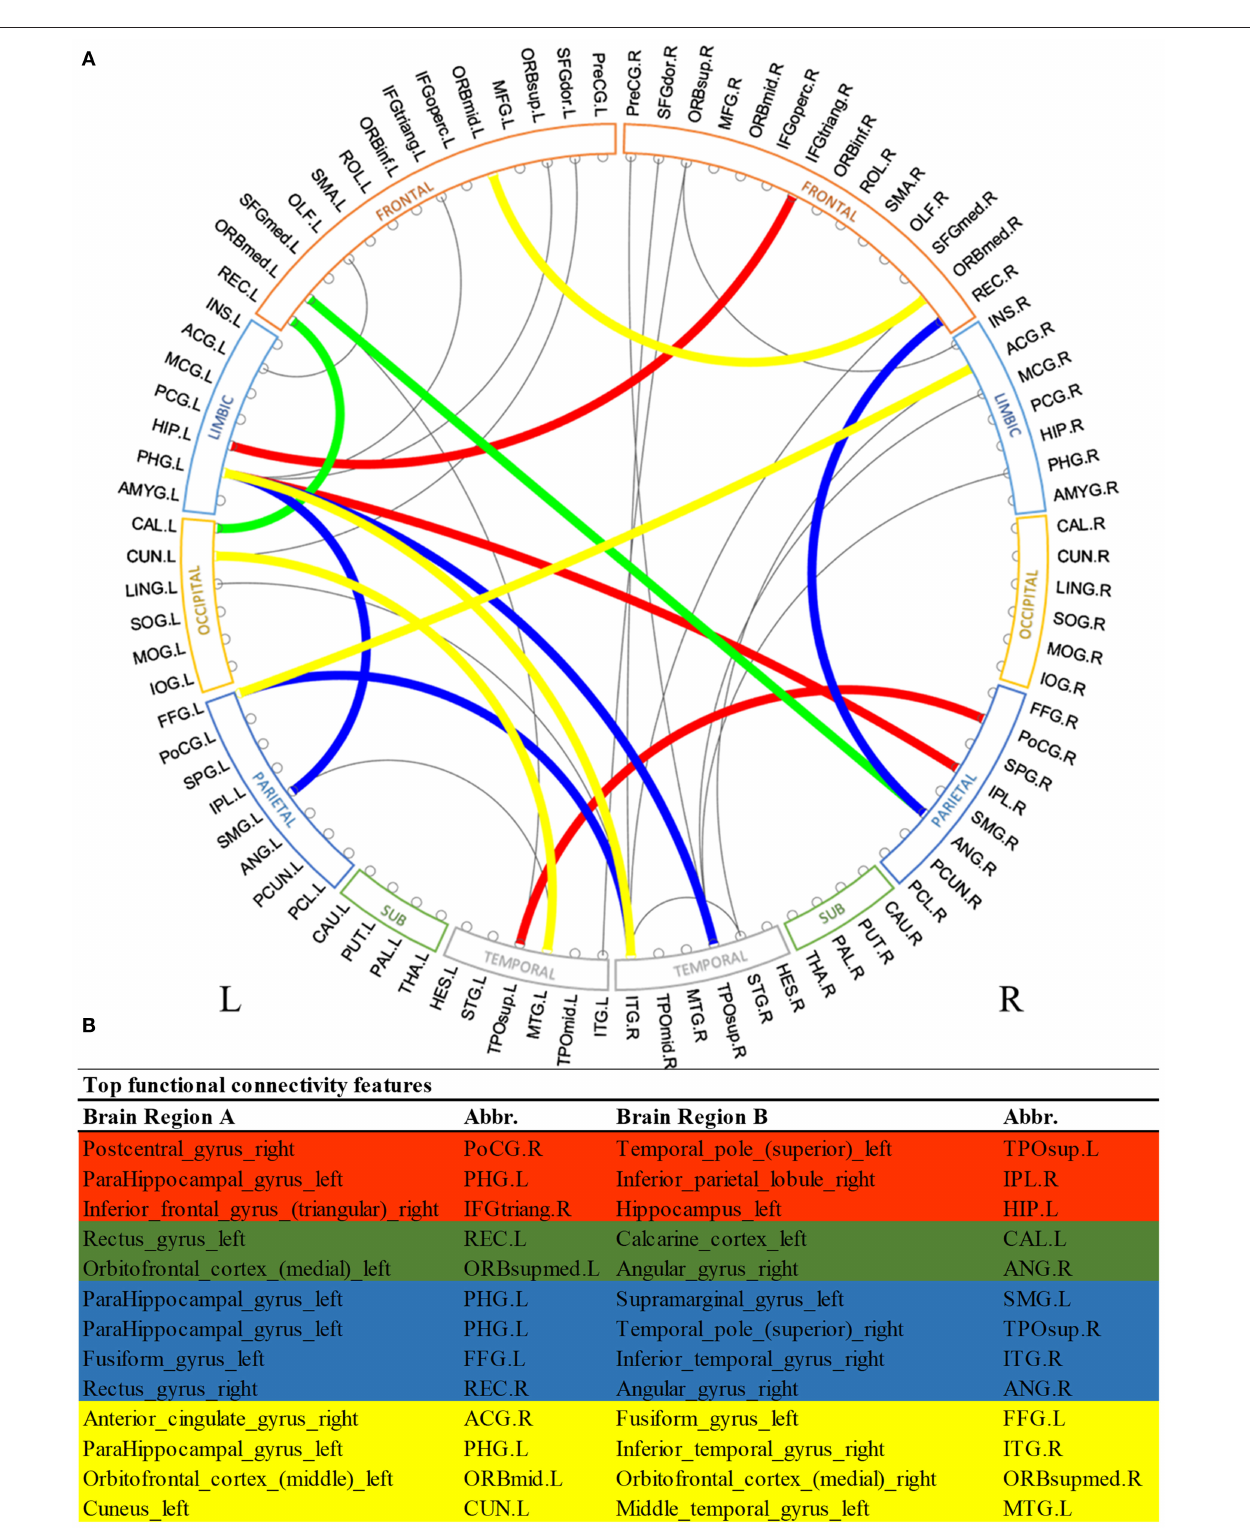
FIGURE 2 | Top discriminative region-to-region functional connections for early prediction of cognitive, language, and motor deficits. (A) circos plot visualization; (B) Full names and abbreviations table. Three common connections were identified to be important for the prediction of all three deficits (red); five common connections were identified to be predictive of both cognitive and language deficits (red and green); seven common connections were identified to be predictive of both language and motor deficits (red and blue); and seven common connections were identified to be predictive of both cognitive and motor deficits (red and yellow).